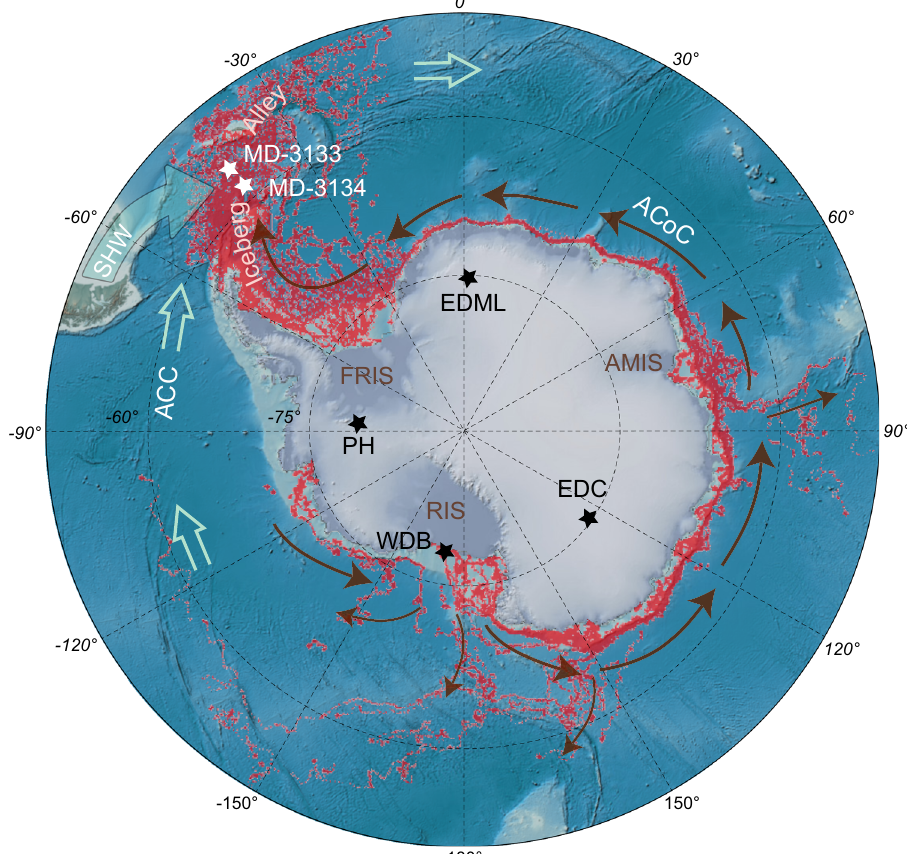
Fig. 1 Location map and iceberg trajectories. Bathymetric map with DEM color shaded relief and Antarctic basemap (IBSCO/GEBCO08) (details at https://maps.ngdc.noaa.gov/viewers/bathymetry/). Sites MD07-3133 and MD07-3134 (white stars) are located in Scotia Sea ’ s Iceberg Alley. Red underlain pattern shows trajectories of large ( ≥ 5km in length) icebergs calving off the Antarctic ice shelves between 1999 and 2009 (ref. 25 ). An animated version including iceberg trajectories from 1976 to 2019 was put together by PixleMoversAndMakers.com and can be viewed online (https://www.youtube.com/ watch?v = iHySJkuoENk). Brown arrows indicate the general circum-Antarctic drift of icebergs that mainly follow the counterclockwise fl ow of the Antarctic Coastal Current (ACoC). Floating ice shelves are labeled in brown text (FRIS, Filchner-Ronne Ice Shelf; RIS, Ross Ice Shelf; AMIS, Amery Ice Shelf). Antarctic sites referred to in this study are shown by black stars (EDML, Epica Dronning Maud Land ice core; EDC, EPICA Dome C ice core; PH, Patriot Hills blue ice fi eld; WDB, Whales Deep Basin, Ross Sea). Southern Hemisphere Westerlies (SHW) indicate Patagonia as main dust source and Iceberg Alley in its direct trajectory. The clockwise fl ow of the Antarctic Circumpolar Current (ACC) is indicated by open light blue